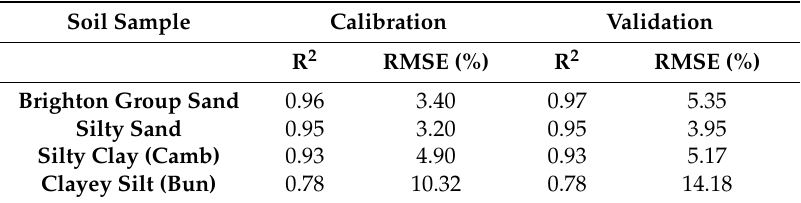
Table 5. Cross validation analysis for the Rectangular sensor for each soil. Soil